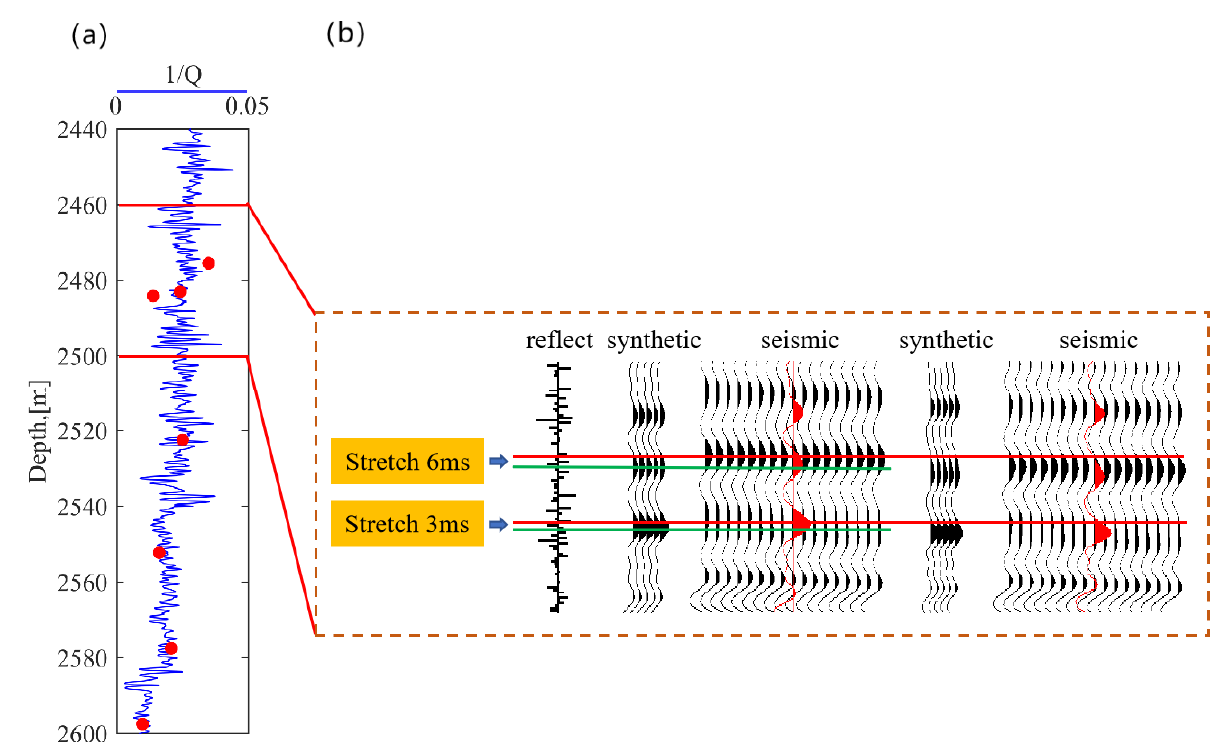
Figure 10. ( a ) Comparison of Q − 1 results by the WIGED model using logging data and data from core measurements. ( b ) Well-to-seismic calibration before and after using Q − 1 results from the WIGED method as a guidance.